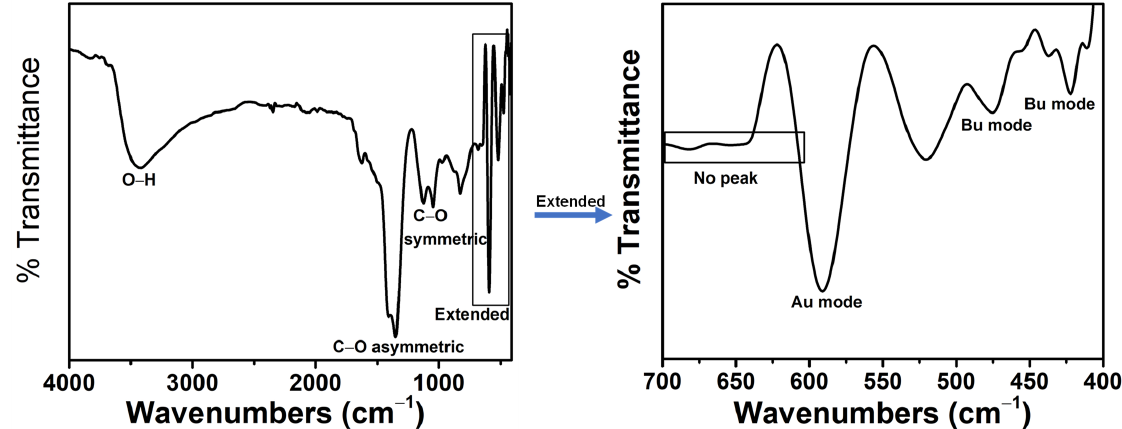
Figure 2. FT-IR spectrum of bio-reduced CuO NPs.